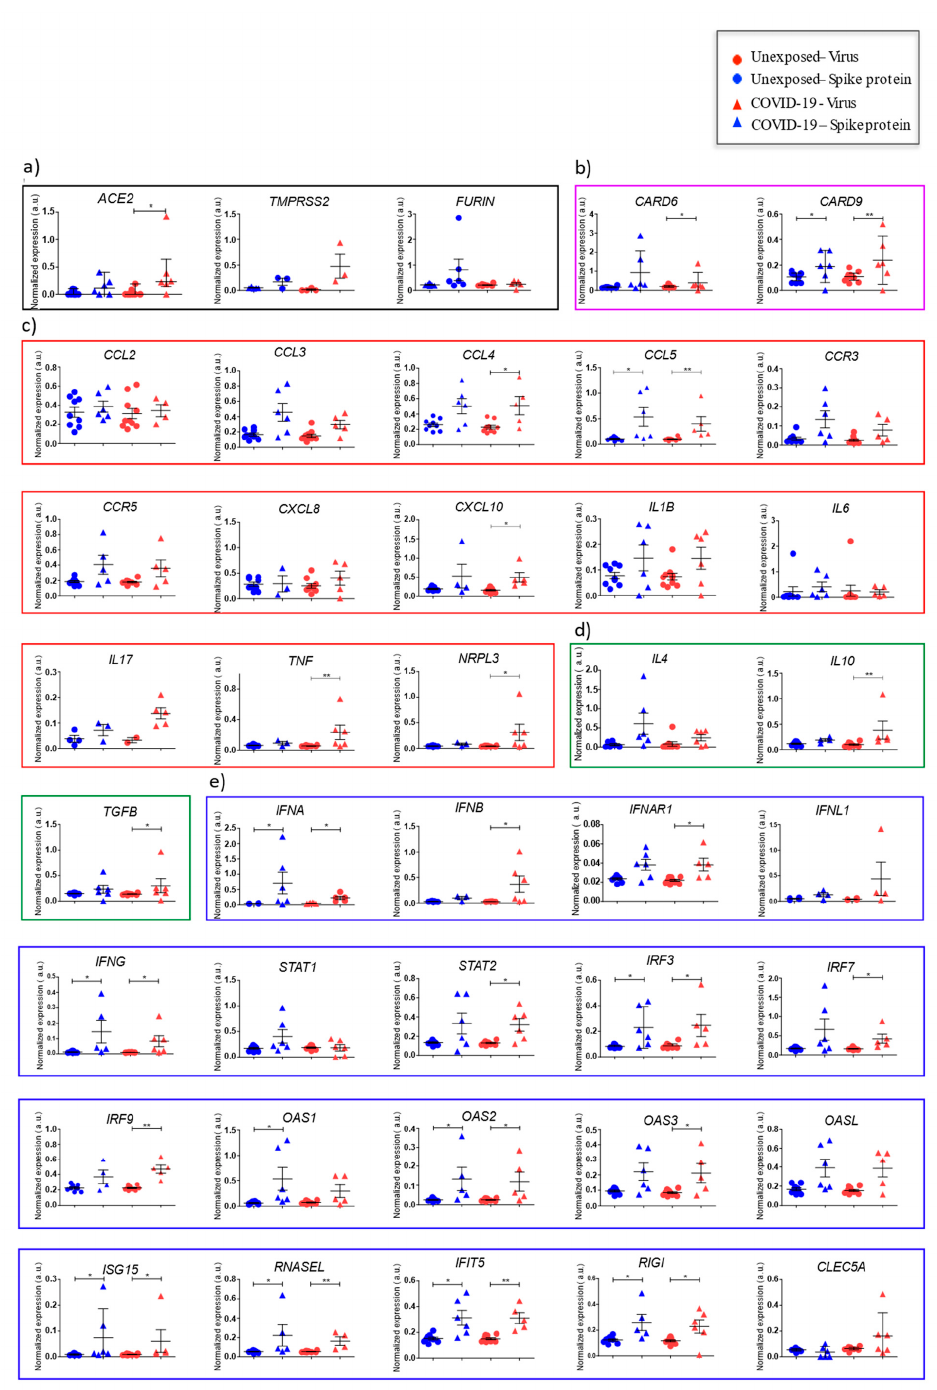
Figure 6. Normalized gene expression of peripheral blood mononuclear subset cells from individuals exposed to SARS- CoV-2 or otherwise after stimuli with spike SARS-CoV-2 protein. Detailed scatted dot plots show normalized expression for genes analyzed in COVID-19 (triangular shapes) or unexposed individuals (circular shape), according to experimental stimuli with spike protein (blue dots) or SARS-CoV-2 (red dots). The number of dots varies according to gene analyzed due to failed amplifications. Boxes represent the median and vertical bars as well as the standard error of normalized expression for each experimental group analyzed using references genes RPL13 and 18S. Genes were clustered in boxes according to biological/immunological functions: SARS-CoV-2 receptors (black) ( a ), apoptosis (purple) ( b ), inflammation (red) ( c ), regulation of inflammation (green) ( d ), and innate antiviral response (blue) ( e ). Graphics and statistical comparisons of normalized expression for unexposed and COVID-19 using Mann–Whitney test in software GraphPad Prism 8.4.2. * p < 0.05, ** p < 0.01, and *** p <